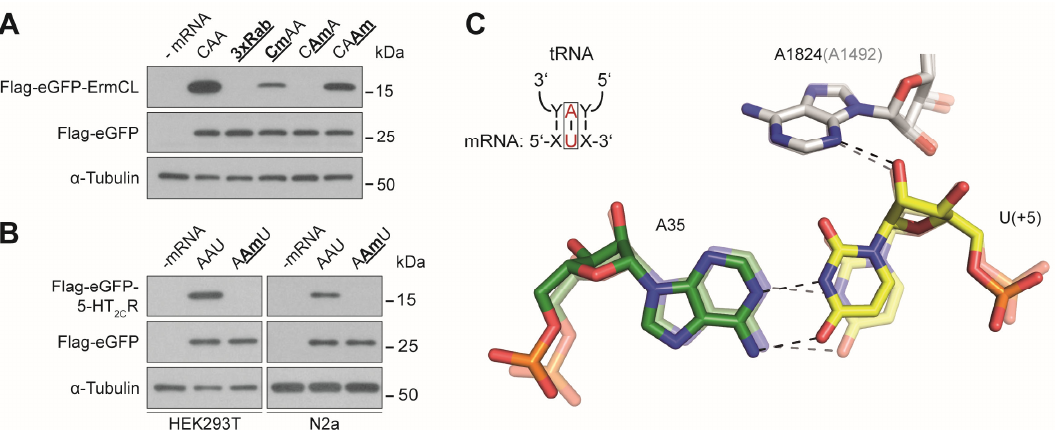
Figure 3. Effect of Nm on translation elongation. ( A ) Western blot analysis of translation products carrying Nm at the codon 147 of the reporter mRNA and ( B ) at the second nucleotide of the AAU codon within the sequence context of the 5-HT 2c R mRNA. ( C ) Structure of the second base pair of the codon-anticodon interaction and the interaction with A1824 (A1492) of the 18S rRNA (16S rRNA) of the 40S (30S) ribosomal subunit. The eukaryotic decoding center is depicted in the foreground (modified from [54]), the E. coli decoding center in the background (modified from [55]).